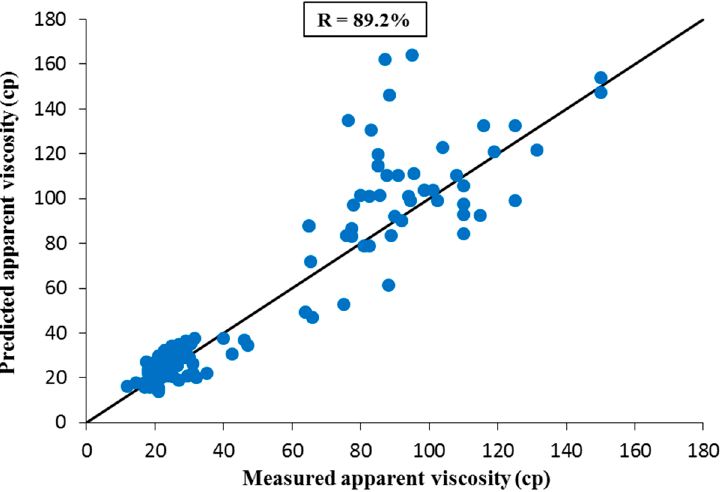
Figure 6. Cross-plot of the (measured) experimental and predicted apparent viscosity from the Pit's [11] correlation. Table 3. The statistical accuracy of the developed correlation, literature correlation and artificial neural network (ANN) model.